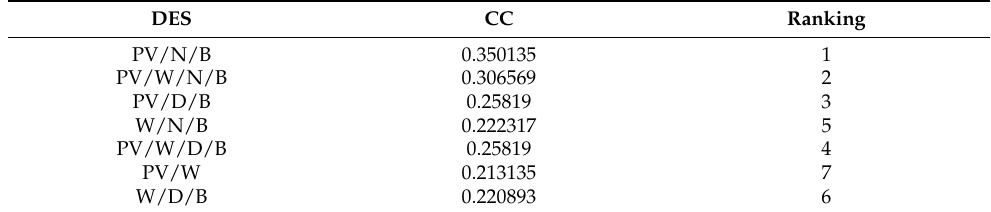
Table 11. Estimation of the coefficient of closeness and